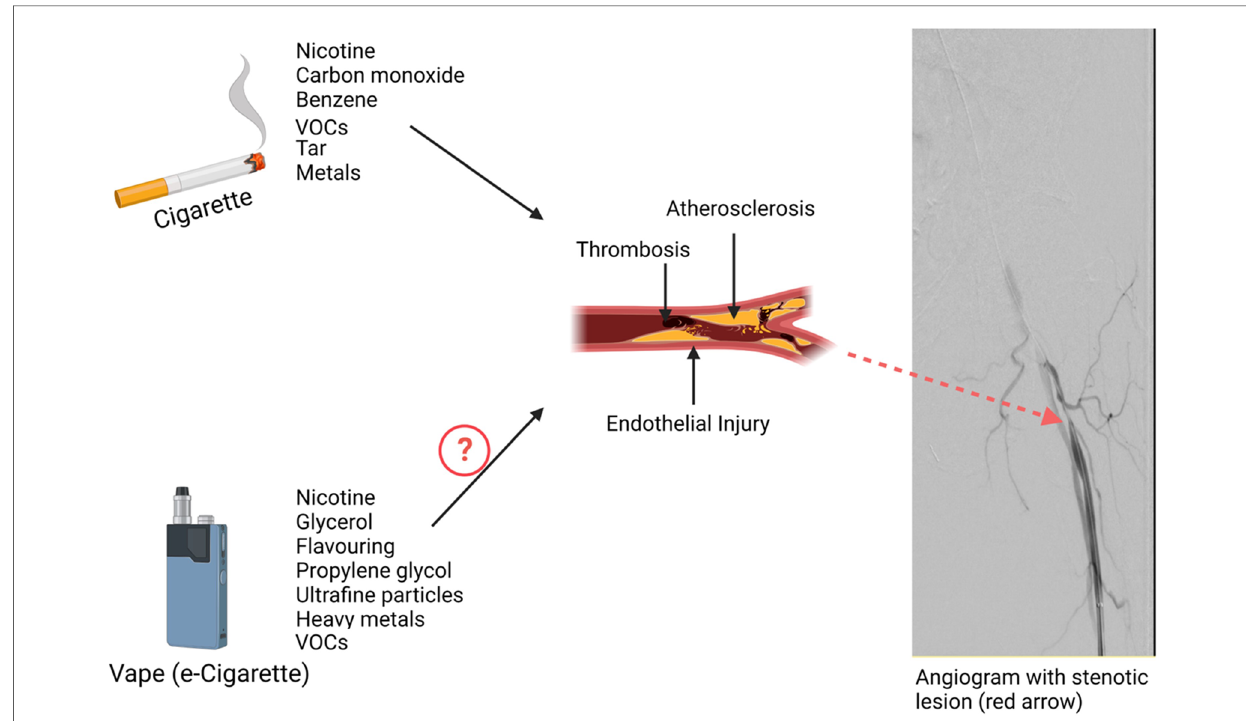
FIGURE 1 Impact of tobacco products on Peripheral Artery Disease (PAD). Combustible cigarettes release multiple potentially harmful constituents into tobacco smoke that induce endothelial injury, promote thrombosis, and accelerate atherothrombosis. Together the toxins in tobacco smoke adversely in fl uence the peripheral vasculature leading to heightened PAD incidence and worse outcomes with established